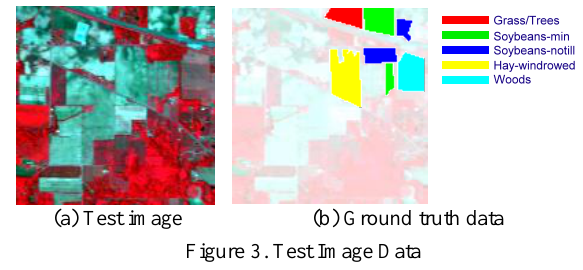
Figure 3. Test Image Data